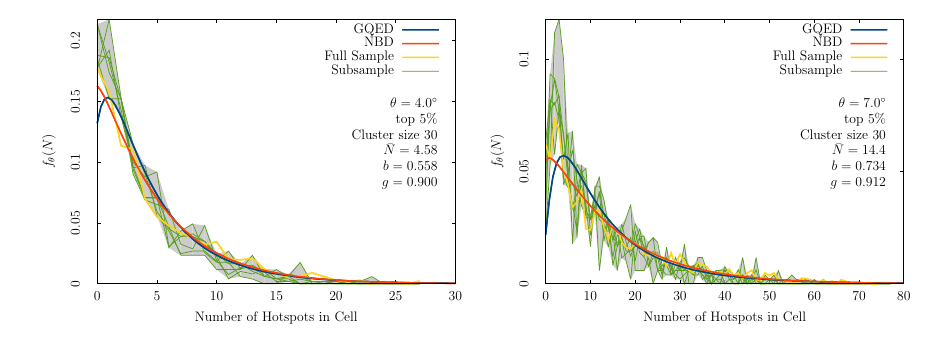
Figure 2. Counts-in-cells for di ff erent resampling windows for cell sizes of 4 . 0 ◦ and 7 . 0